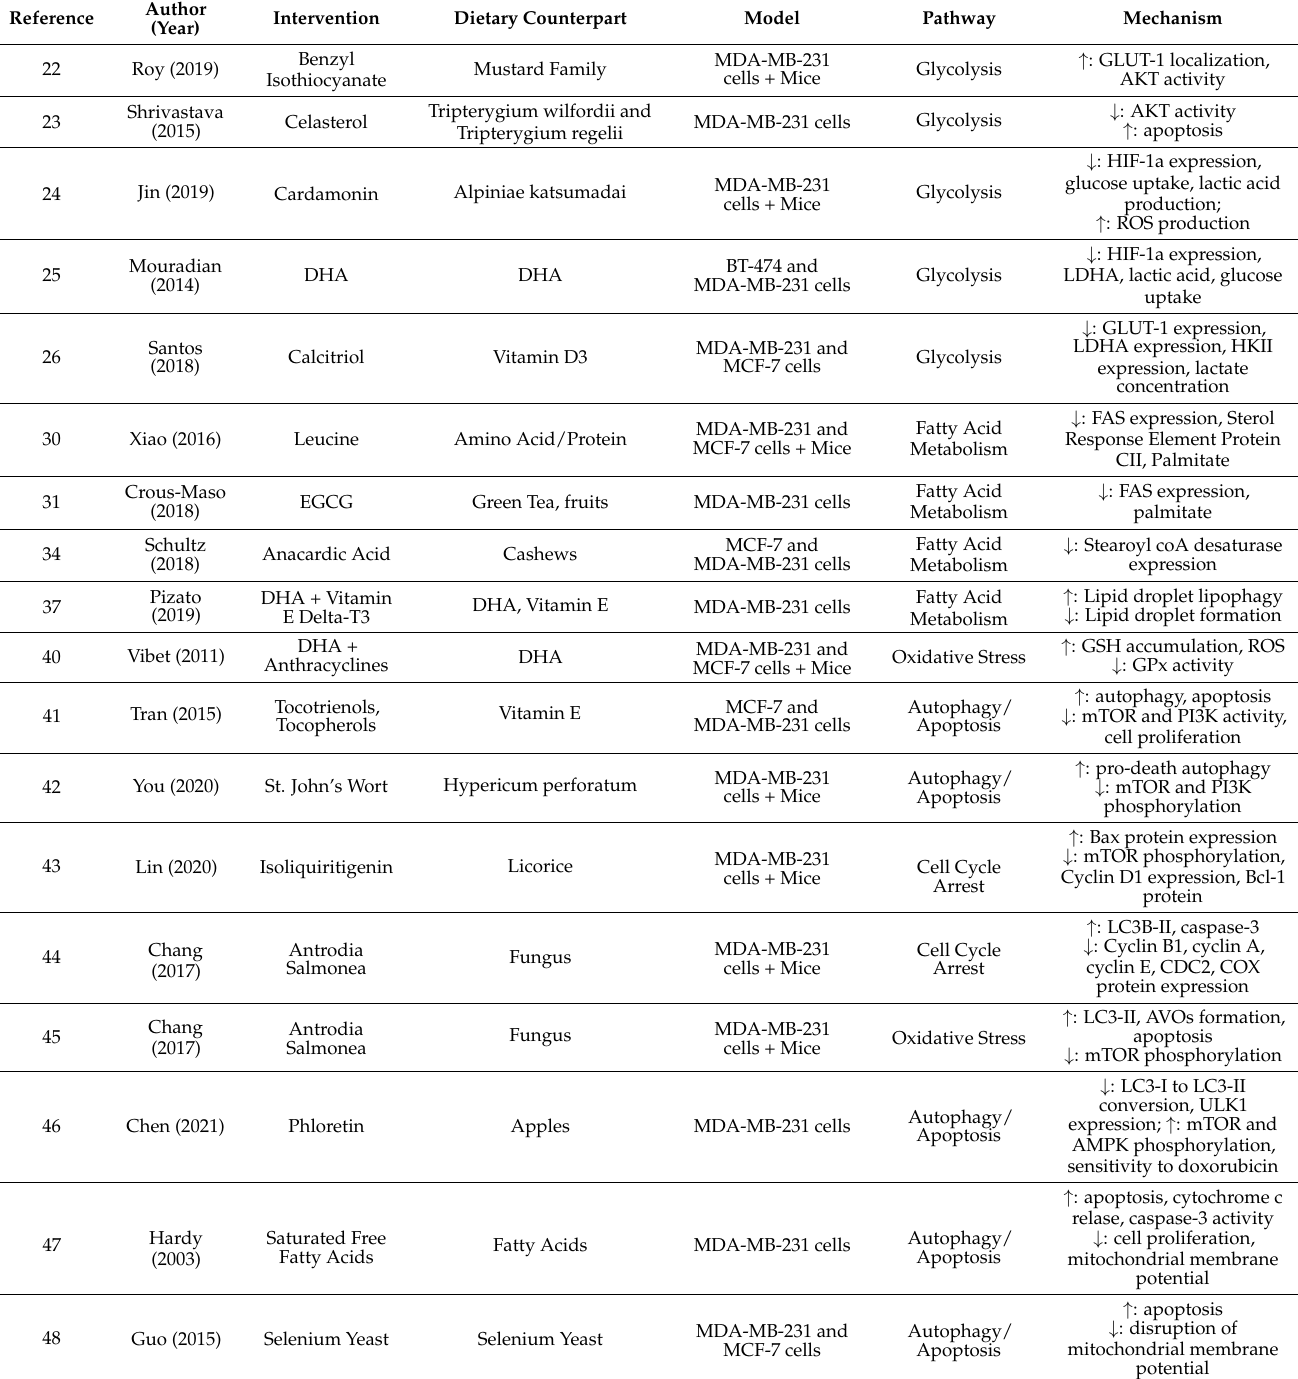
Table 1. Summary of reviewed